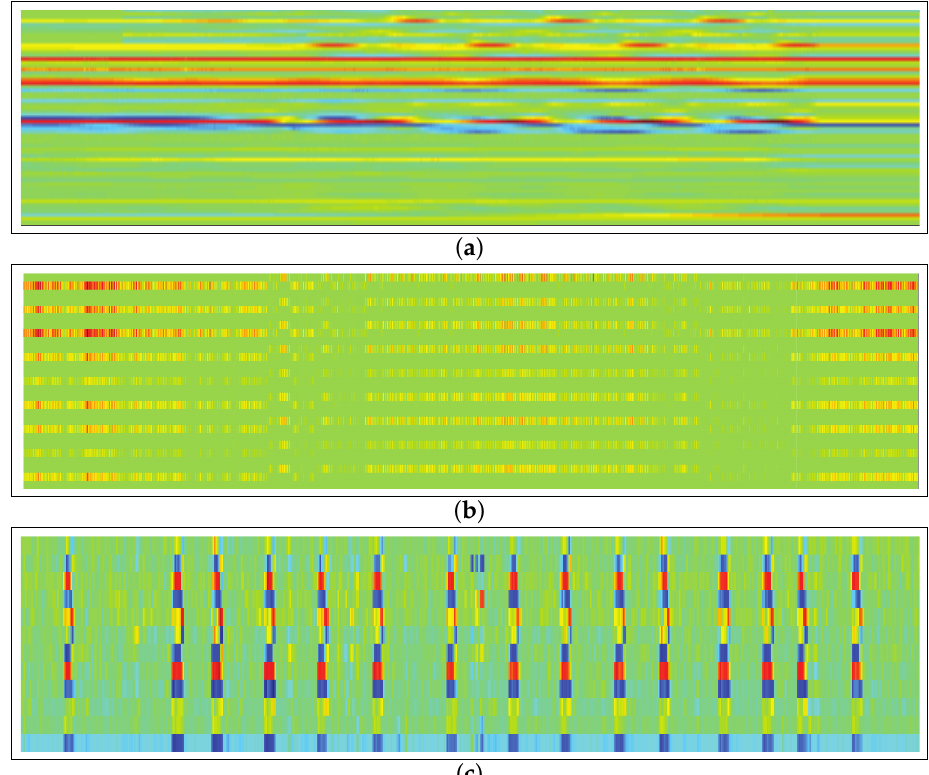
Figure 8. Heatmap visualization of sample time series: each row corresponds to a different variate (best viewed in color). ( a ) MOCAP sample. ( b ) Building energy sample. ( c ) BirdSong